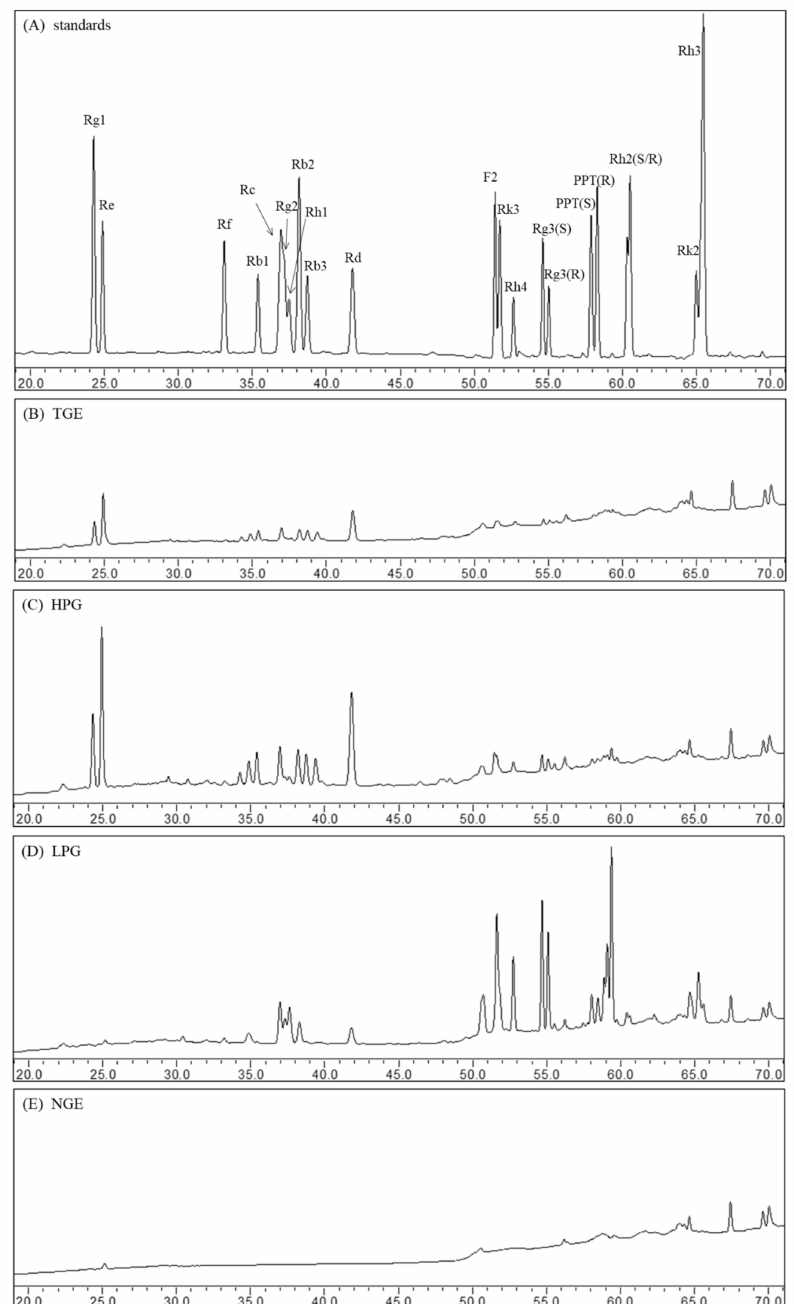
Figure 1. The HPLC chromatograms of ginsenoside standards ( A ), TGE ( B ), HPG ( C ), LPG ( D ), and NGE ( E